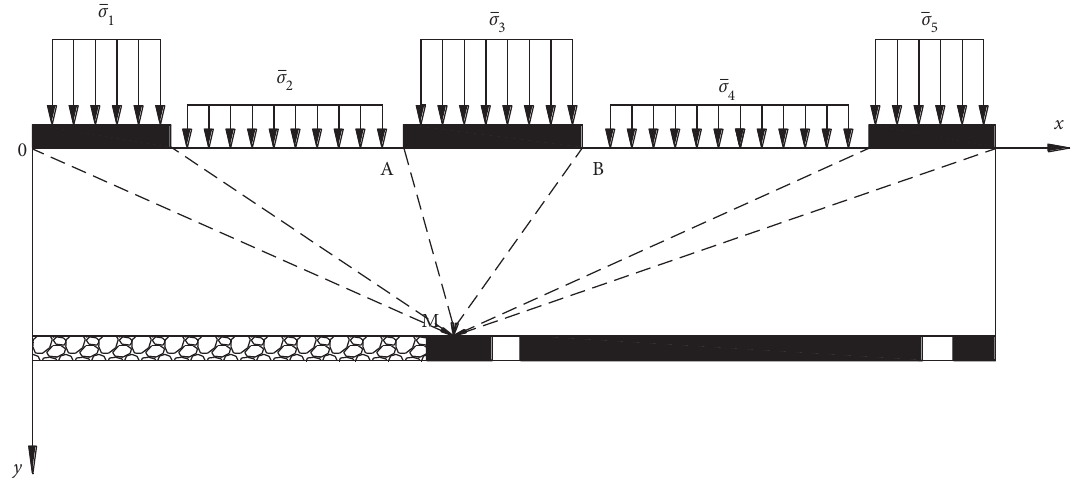
Figure. 6: Stress transfer model of overlying coal pillars and goaf